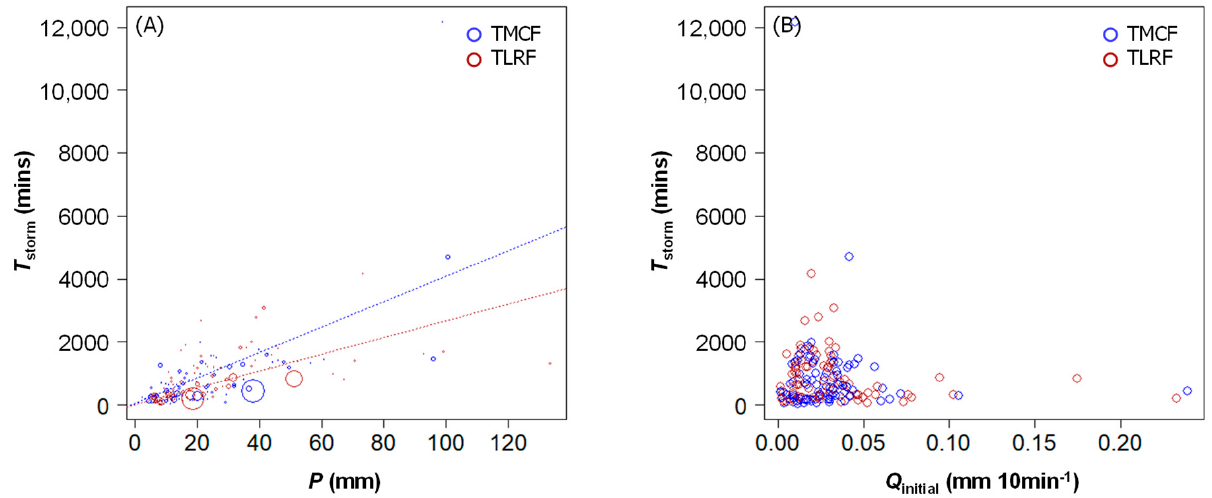
Figure 6. ( A ) T storm versus P . Increasing point size corresponds to increasing Q initial and ( B ) T storm versus Q initial .